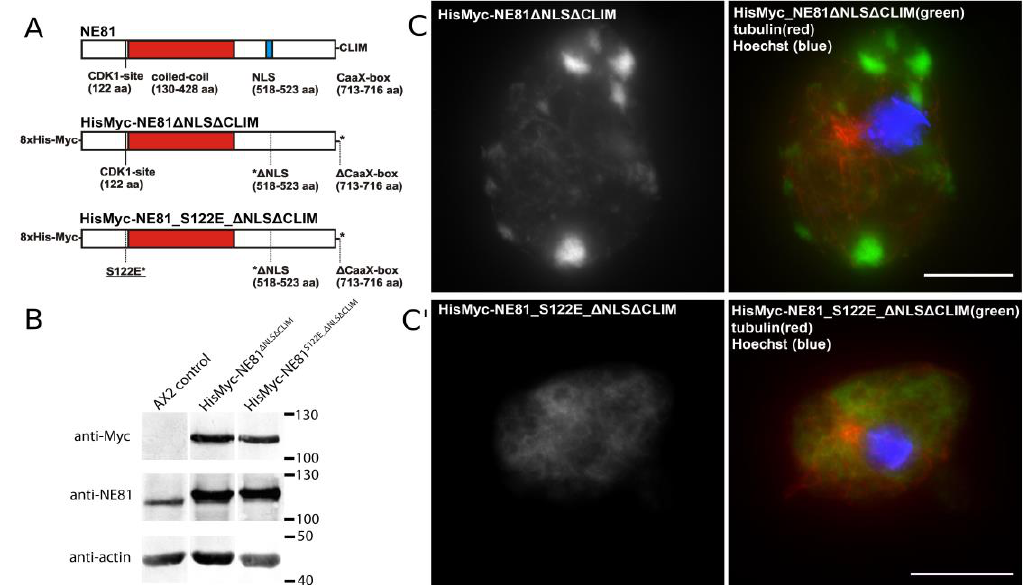
Figure 4. Formation of cytosolic HisMyc-NE81ΔNLSΔCLIM clusters requires an intact S122 target for CDK1. ( A ) Domain overview of HisMyc-NE81 variants used in this work. ( B ) Immunoblots of whole-cell extracts showing relative expression levels of endogenous NE81 compared to the tagged variants. The anti-actin staining is shown as a loading control. ( C , C′ ) Expansion microscopy employing an LCI PlanNeo 1.3/63× objective. Cells were fixed with glutaraldehyde and stained with Hoechst33342, anti-myc/anti-mouse-AlexaFluor 488, and anti-tubulin/anti-rat-AlexaFluor 568 as indicated. Cytosolic HisMyc-NE81ΔNLSΔCLIM clusters are present only in cells with a native serine 122 ( C ), but not in cells carrying the phosphomimetic S122E mutation ( C′ ). Expansion factors are 3.2 in ( C ) and 3.7 in ( C′ ); scale bars = 5 µm (referring to the original size).